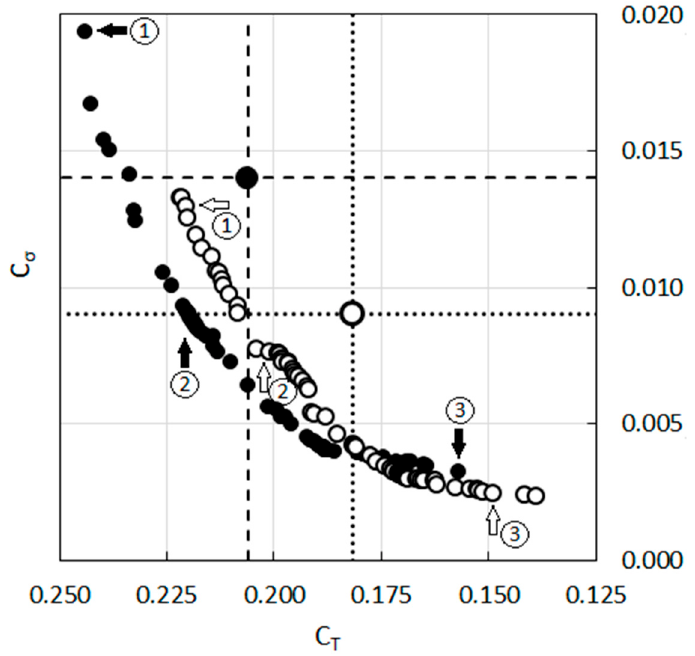
Figure 9. Predicted Pareto fronts of feasible solutions of optimization. Full circles: L/C = 3, Empty circles: L/C = 6.